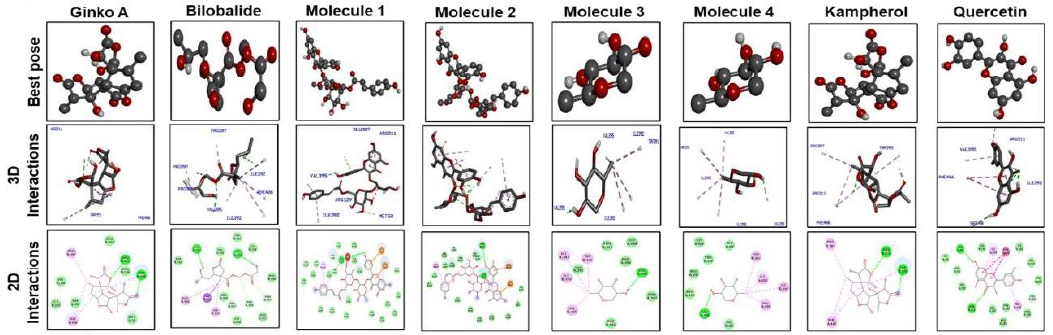
Figure 6. The best pose and docking results are presented here for ginkgolide A, bilobalide, 3-O-(2 (cid:48) -O-(6 (cid:48) -O-(p-coumaroyl)- β - d -glucosyl)- α - l -rhamnosyl) kaempferol (Molecule 1), 3-O-(2 (cid:48) -O-(6 (cid:48) -O-(p-coumaroyl)- β - d -glucosyl)- α - l -rhamnosyl)quercetin (Molecule 2), 3-O-(2 (cid:48) -O,6 (cid:48) -O-bis( α - l -rhamnosyl)- β - d -glucosyl) kaempferol (Molecule 3), 3-O-(2 (cid:48) -O,6 (cid:48) -O-bis( α - l -rhamnosyl)- β - d -glucosyl) quercetin (Molecule 4), quercetin, and kaempferol, which were docked into iNOS. Both 2D and 3D shapes of the drug-receptor complex were visualized by DSV.